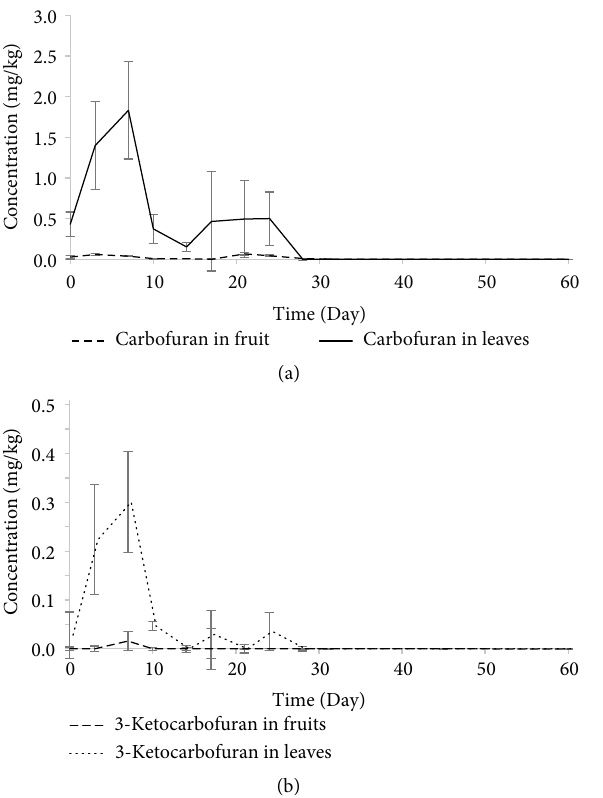
Figure 4: (a) Carbofuran and (b) 3-ketcarbofuran residues in fruits and leaves of brinjal plants.